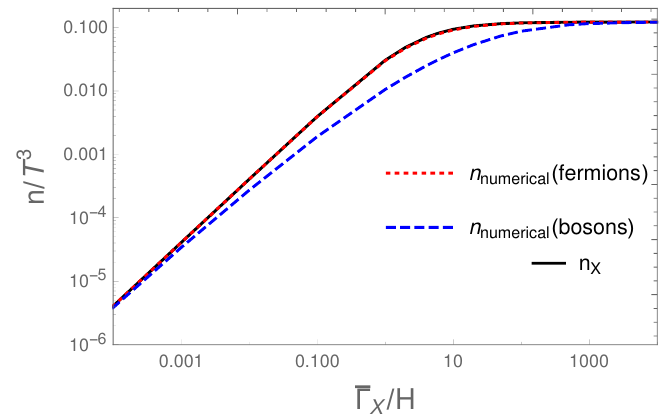
Figure 4. The momentum integrated distributions for the cases of decay into bosons (dashed line) and decay into fermions (dotted line). The solid line is the result of the solution given by eq. (2.12). distribution at asymptotically large times, while the present one applies generically to a relativistic distribution in an in(cid:13)ationary regime and reaches a stationary state in only a few